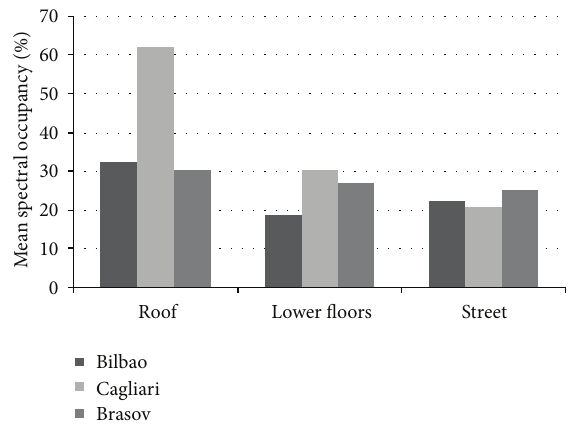
Figure 4: Mean spectral occupancy for the three cities in suburban environment.